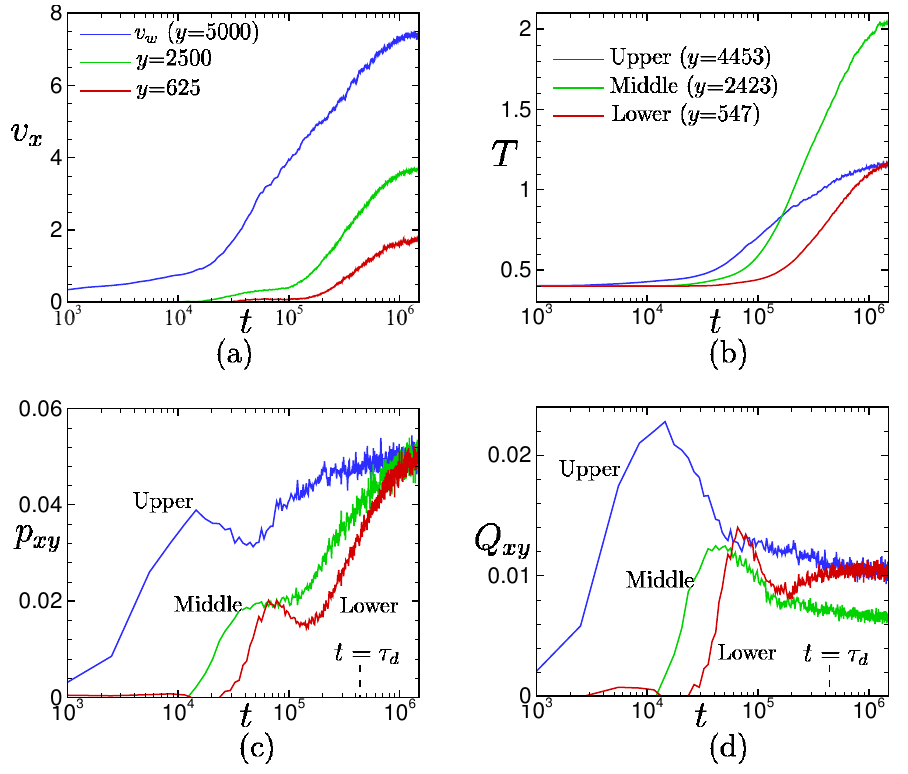
Figure 10. Time evolutions of ( a ) local velocity, ( b ) temperature, ( c ) shear stress, and ( d ) bond orientation for the drive force p w = 0.05. See also the caption in Figure